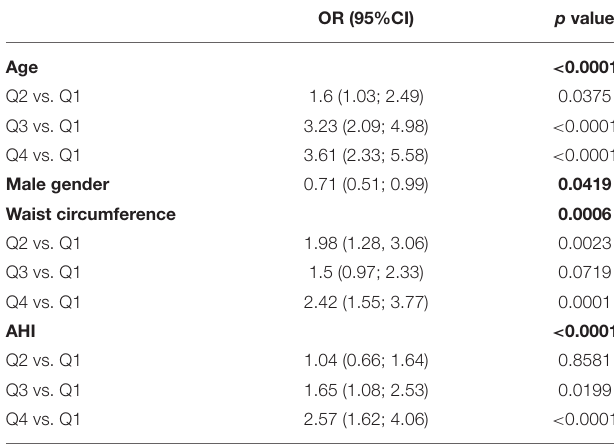
TABLE 4 | Respective contribution of age, gender, waist circumference, and TABLE 3 | Respective contribution of age, gender, BMI, and apnea severity to low apnea severity to low IGF-1 levels (below the median). IGF-1 levels in multivariate analysis (below the median). OR (95%CI) p value OR